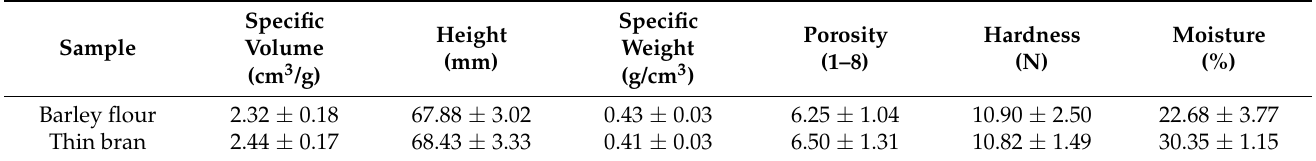
Table 8. Evaluation of physical properties of the bread samples produced using different types of supplementation: two-factor ANOVA (analysis of variance) referred to the two flours: barley flour and thin bran (data are means ± standard deviations).